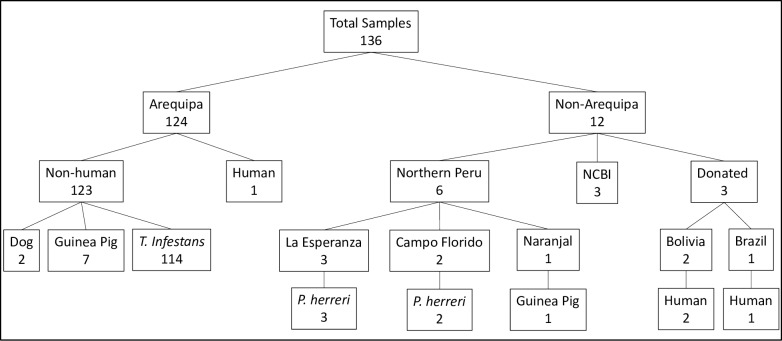
Number of samples collected from each host species per location.Most samples (N = 124) were collected in Arequipa and 6 from small towns in northern Peru. 3 isolates were provided by the Infectious Diseases Research Laboratory at Universidad Peruana Cayetano Heredia. Maxicircle sequences for 3 T. cruzi lineages were downloaded from the NCBI database.